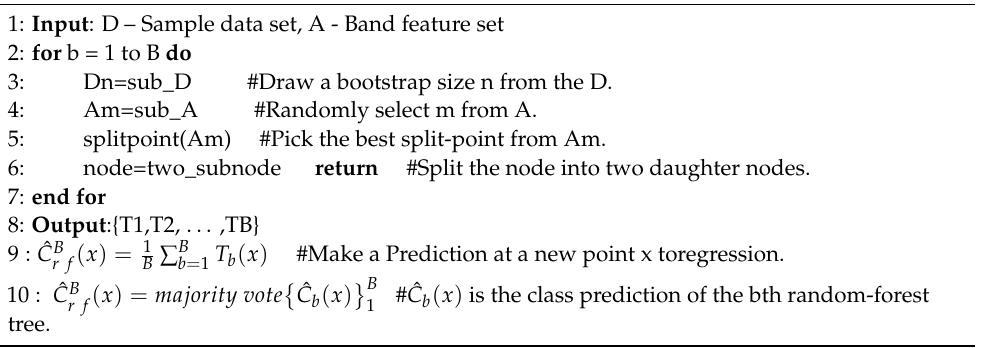
Algorithms 1. The implementation process and part of